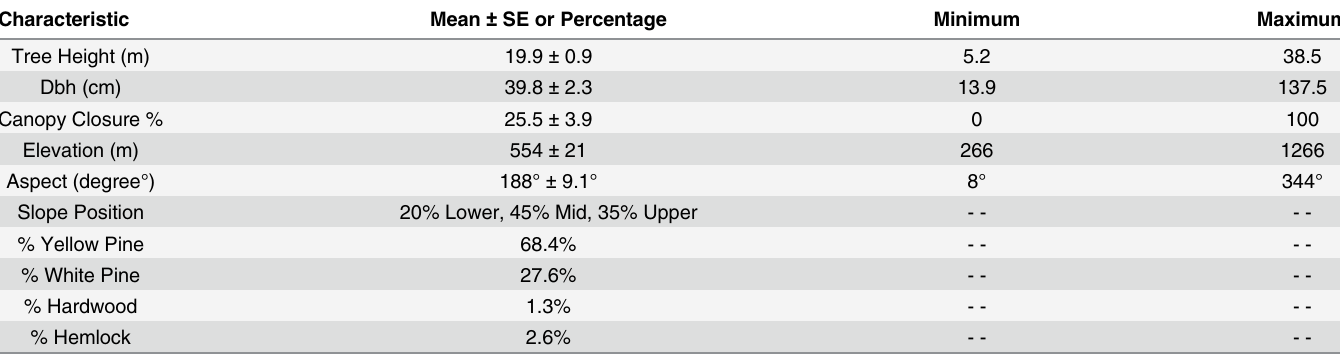
Table 2. Summary data for Myotis sodalis roosts.